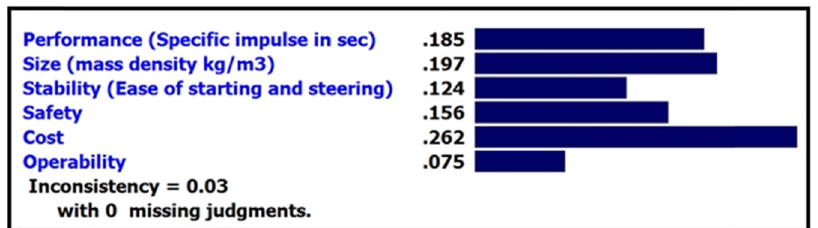
Figure 2: Weights of the main factors with respect to the main goal with inconsistency